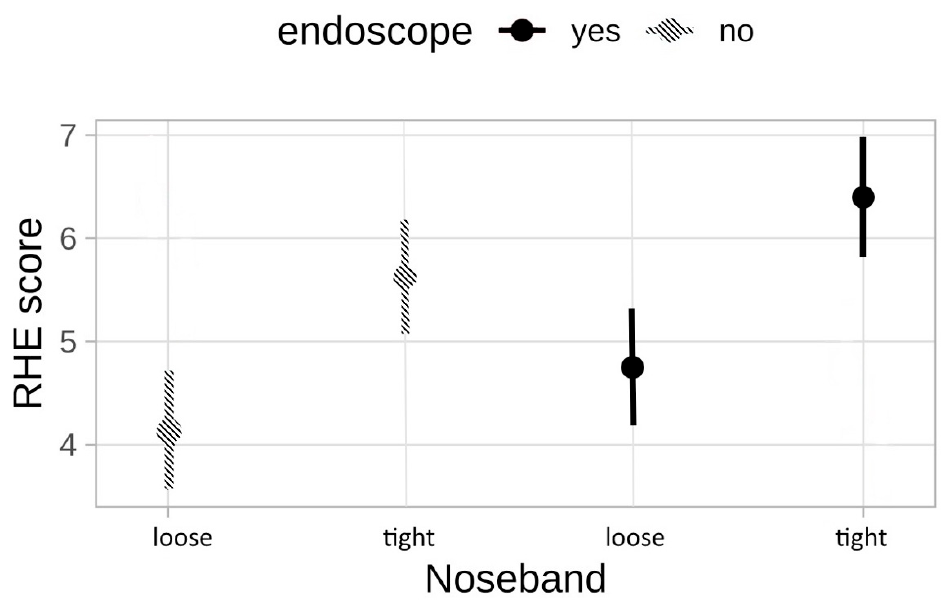
Figure 4. Parameters of the Ridden Horse Ethogram (RHE) shown by the horses ridden with loose or tight nosebands and with and without an inserted endoscope. There was a significant increase in the displayed stress behavior in horses ridden with tight nosebands regardless of the inserted endoscope ( p = 0.0003).